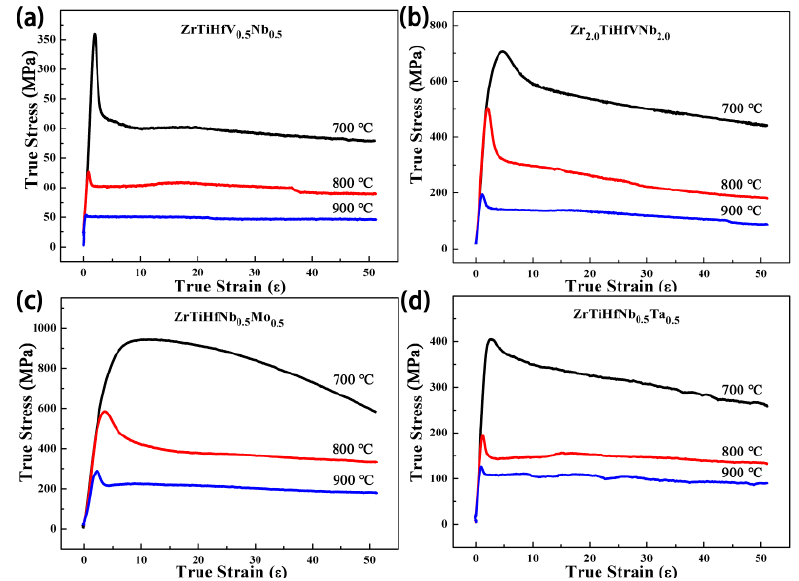
Figure 9. The high-temperature compression stress–strain curves of the alloys: ( a ) ZrTiHfV 0.5 Nb 0.5 ; ( b ) Zr 2.0 TiHfVNb 2.0 ; ( c ) ZrTiHfNb 0.5 Mo 0.5 ; ( d ) ZrTiHfNb 0.5 Ta 0.5 .